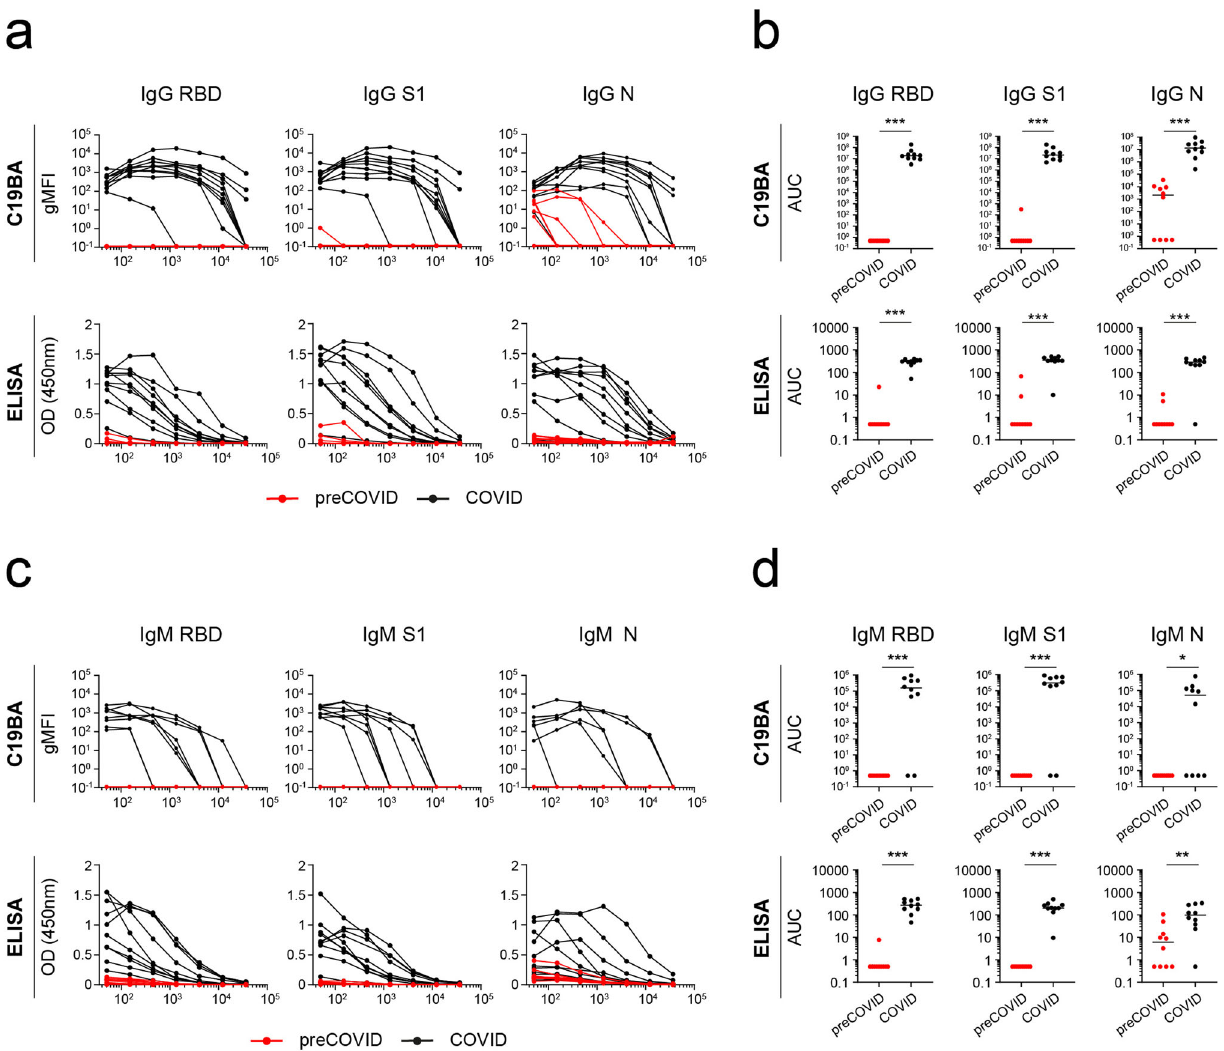
Fig. 3 Identi fi cation of SARS-CoV-2 IgG and IgM seroconversion by C19BA. a Titration curves of the reactivity of individual serum samples against RBD, S1, and N proteins measured by fl ow cytometry against IgG by C19BA (top) and ELISA (bottom) for each cohort: preCOVID (red, n = 10) and COVID (black, n = 10). COVID serum samples were obtained at time of hospital admission (PCR + ). b AUC values for the experiment shown in a . c Titration curves of the reactivity of individual serum samples against RBD, S1, and N proteins against IgM by C19BA (top) and ELISA (bottom). d AUC values for the experiment shown in c . Statistical analyses were performed using an unpaired two-tailed Student ’ s t -test. Asterisks represent p values (*** p < 0.001, * p < 0.05, ns not signi fi cant). Horizontal lines represent median